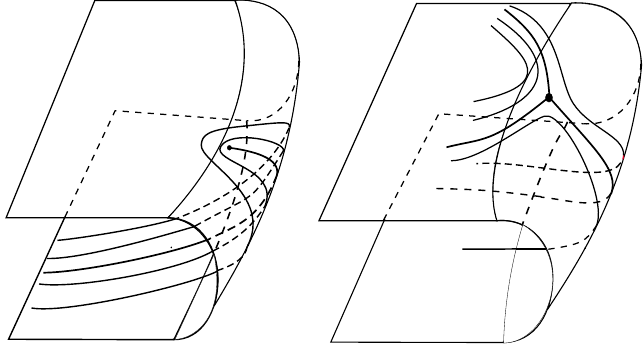
Fig. 2 – Minimal principal foliation of S (cid:20),δ : external and internal